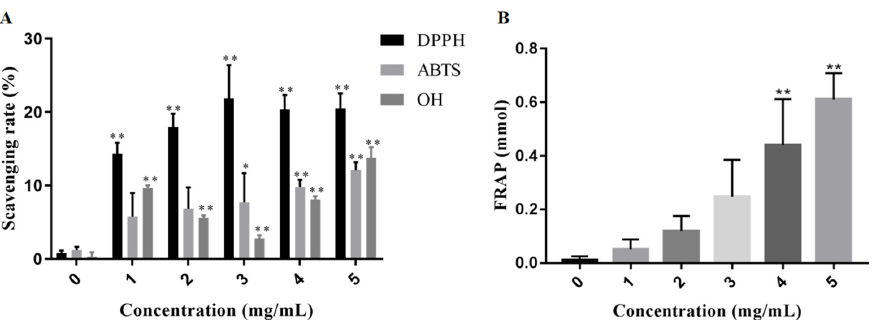
Figure 7. In vitro antioxidant activities of EPS2-1. ( A ) DDPH, ABTS, hydroxyl free radicals scavenging ability; ( B ) FRAP assay of EPS2-1. Data are presented as mean ± SD compared with the control group, * p < 0.05 and ** p < 0.01.